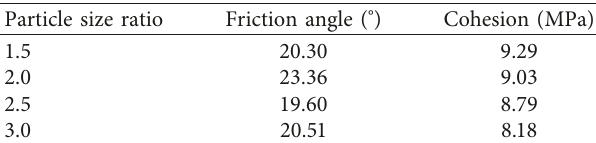
Table 6: Shear strength parameter values of different particle sizes. Minimum particle size (mm)